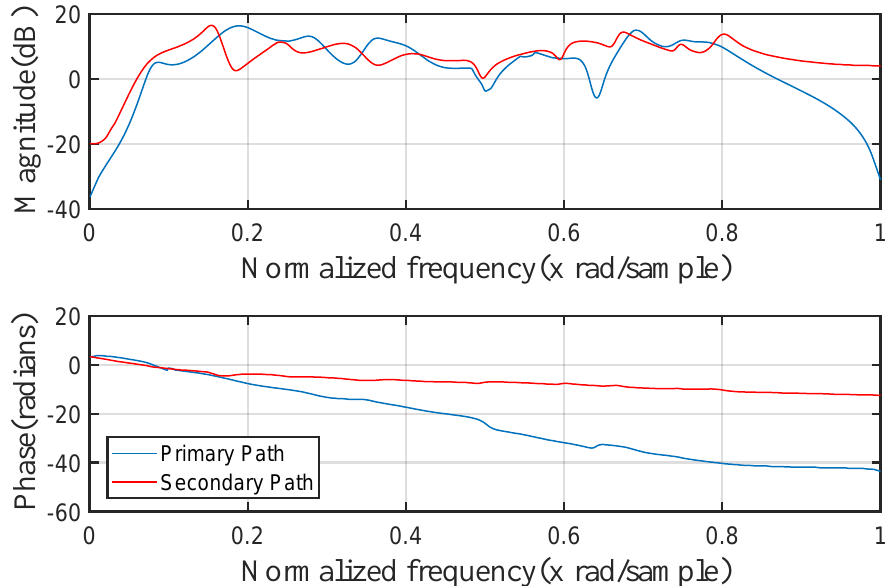
Figure 8. Amplitude and phase response of measured primary and secondary path.